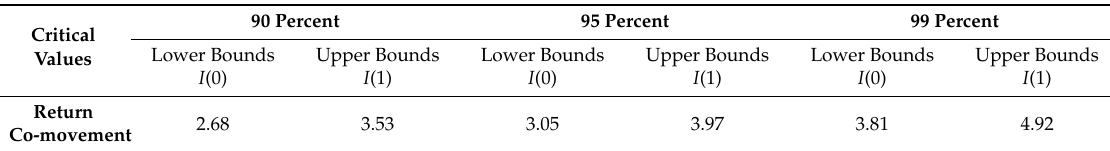
Table 4. ARDL bound test critical values.